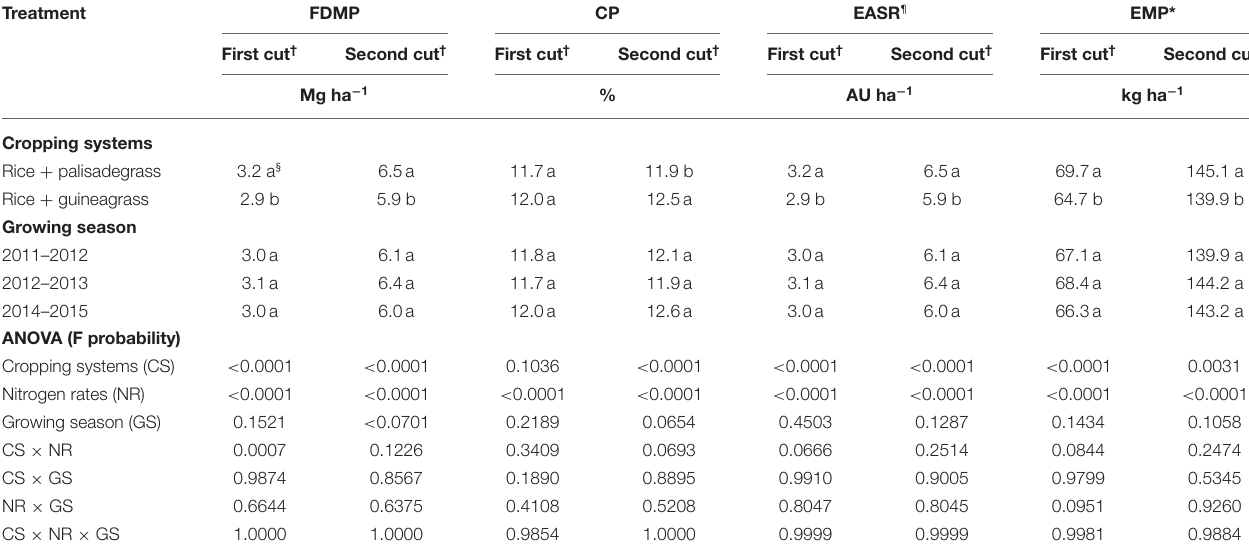
TABLE 3 | Forage dry matter production (FDMP), forage crude protein concentration (CP), estimated animal stocking rate (EASR), and estimated meat production (EMP) in the fall-winter as affected by cropping systems, sidedress nitrogen rates and growing season. Treatment